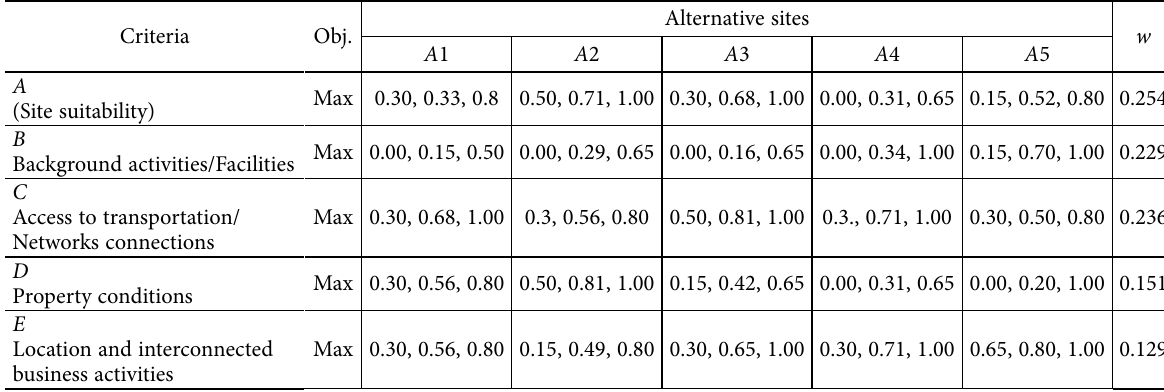
Alternative sites